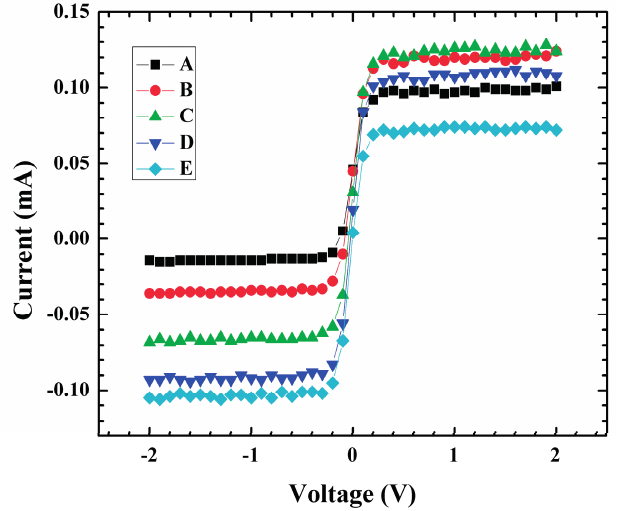
Figure 7. Output voltage vs. current measurements for various light positions (A = − 0.4 mm,